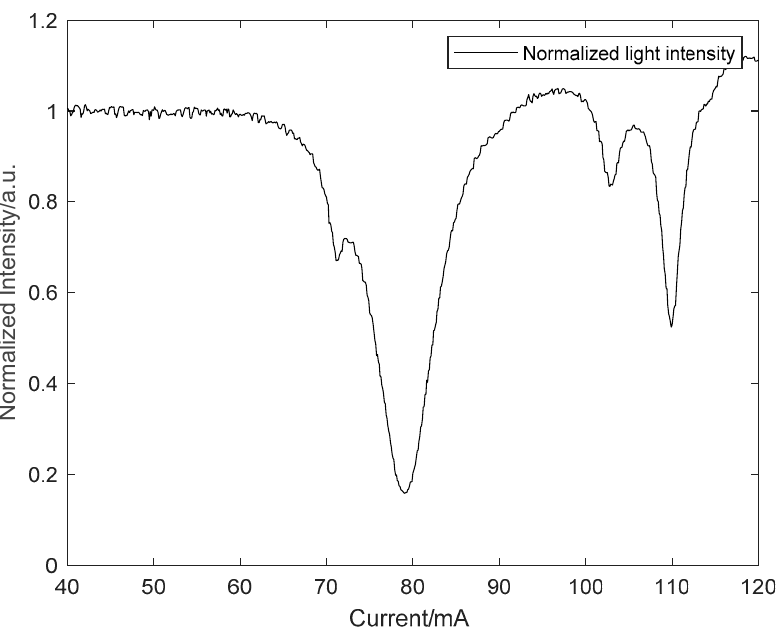
Figure 6. The cavity-enhanced absorption spectrum in the situation of the S-polarization direction.